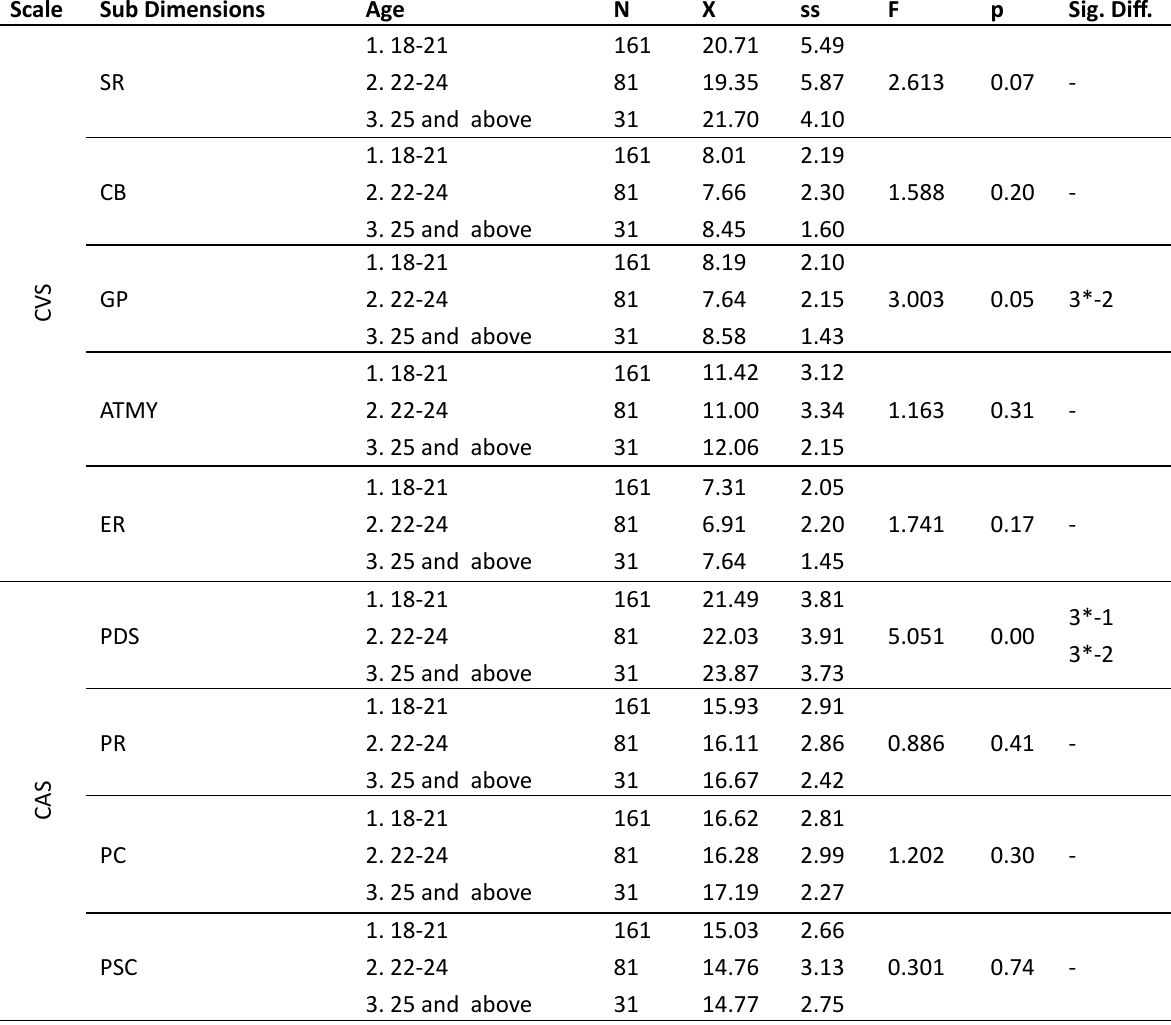
Table 7. Anova-Test results of participants’ CVS and CAS sub-dimensions in terms of the variables of Age